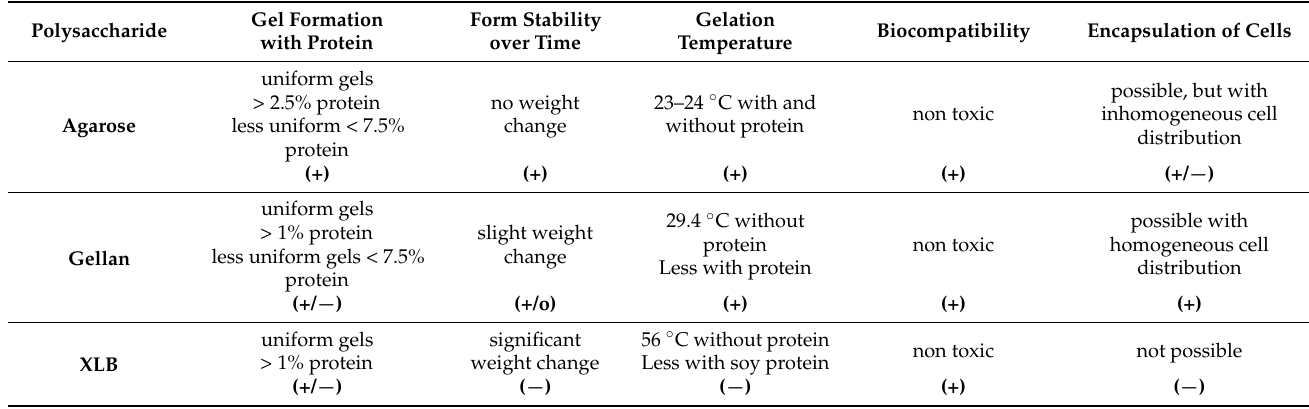
Table 2. Summarized results for different polysaccharides (agarose, gellan and xanthan-locust bean gum blend) with application relevant information: (+) very good properties, (+/o) good properties, (+/ − ) acceptable properties, and ( − ) poor